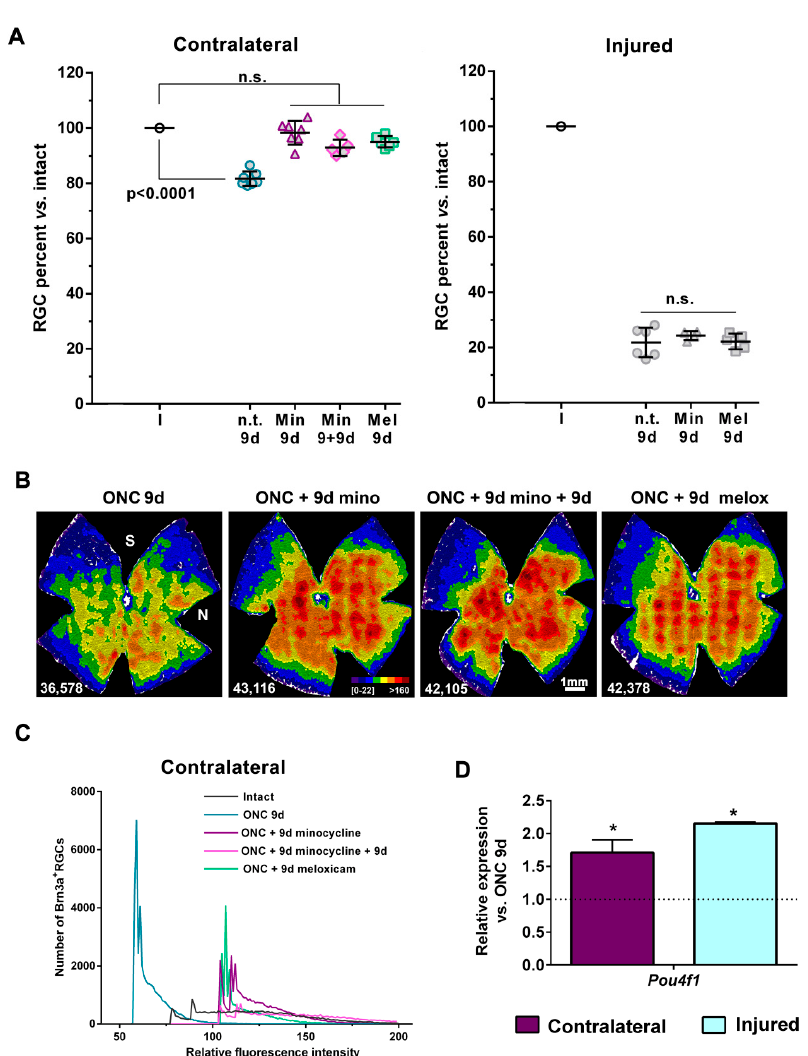
Figure 6. Retinal ganglion cell death in the contralateral retina was rescued by microglial inhibition and by NSAID treatment. ( A ) Scatter graphs showing the percent versus intact (I, 100%) of RGCs in contralateral and injured retinas from animals treated with minocycline (Mi), meloxicam (Mel), or non-treated (n.t.). Minocycline and meloxicam treatments for 9 days rescued RGCs in the contralateral retinas, and this effect lasted 9 days after the last minocycline injection (Mi + 9d). In the injured retinas, however, microglial inhibition did not rescue RGCs. Statistics: one-way ANOVA, Kruskal–Wallis, Dunn ′ s multiple comparisons tests. n.s.: non-significant. See Table 1 for more details. ( B ) Neighbour maps illustrating the topography of surviving RGCs in contralateral retinas from the same groups as in ( A ). These neighbour maps illustrate the number of RGCs around a given RGC in a radius of 0.200 mm with a colour scale (second from the left panel) from 0–25 neighbours (purple) to >160 neighbours (dark red). The bottom left of each map shows the number of RGCs counted in the original retina. S: superior, N: nasal. ( C ) Minocycline treatment maintained Brn3a expression per RGC in the contralateral retinas. x-, y -plot showing the distribution of RGCs according to their expression level of Brn3a. The number of RGCs (ordinate axis) from the groups in ( A ), is plotted against the intensity of their Brn3a signal ( y- axis). The mean intensity of Brn3a expression per nucleus in the contralateral treated retinas was within intact levels. ( D ) Minocycline treatment increased Brn3a mRNA expression in injured and contralateral retinas compared to untreated ones. Bar graphs showing the expression level ± S.E.M. of Pou4f1 (Brn3a transcript) in the injured and contralateral retinas from the ONC + minocycline 9 day group compared to ONC 9 days (dotted line, value 1). * p < 0.05 compared to ONC 9 days (t- test). n = 4 retinas per